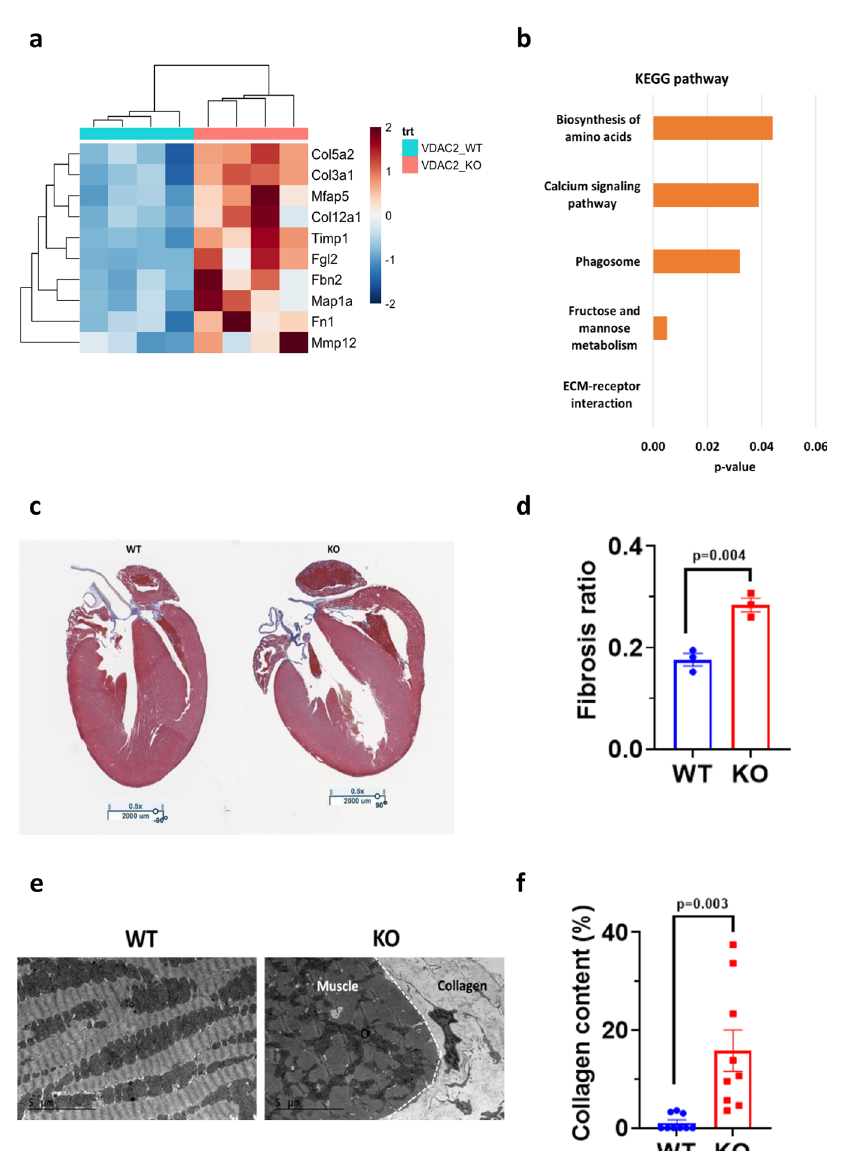
Fig. 6 Altered mitochondrial structure and function in VDAC2-KO. a Representative transmission electron microscopy image at ×800, ×5000 and ×15,000 magni fi cations (scale bar, 10 μ m, 1 μ m, and 500 nm, respectively) ( n = 3); b Number of mitochondria per unit area measured using Adobe Photoshop CC 2019 ( p = 0.0365) ( n = 18 images, N = 3); c Mitochondrial volume fraction measured using Adobe Photoshop CC 2019 using 22 × 14 grid (p = 0.0001) ( n = 18 images, N = 3); d , e Western blot image of DRP1 and lane-loading control VINCULIN and quanti fi cation using Image Studio Lite (version 5.2.5) ( p = ns) ( n = 6); f Representative mitochondrial calcium uptake image produced using MATLAB ( n = 3); g , h Mitochondrial calcium uptake in the fi rst 30 s ( p = ns) and 60 s of calcium pulse ( p = 0.0300) ( n = 3), respectively; i – k Western blot image of MCU ( p = 0.0014) and NCLX ( p = 0.0169) along with respective lane-loading control GAPDH and quanti fi cation using Image Studio Lite (version 5.2.5) ( n = 6). p -value: unpaired two-tailed t -test performed in all comparisons. Data are represented as ±SEM.